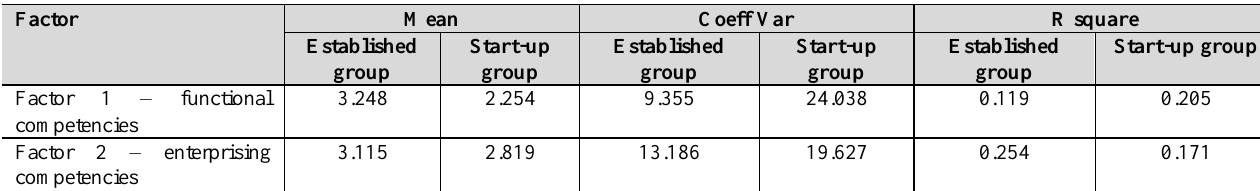
Table 7: ANOVA of the difference between the SMEs on proficiency